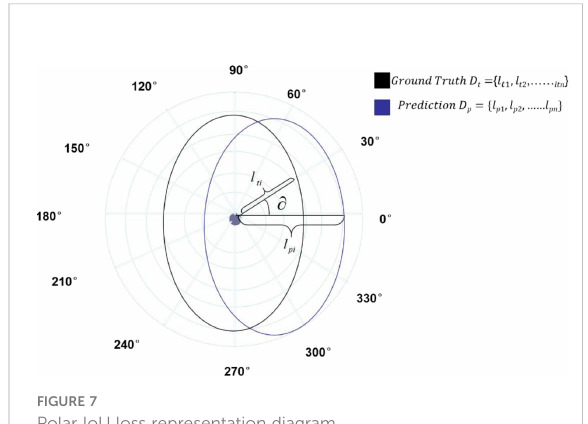
FIGURE 7 Polar IoU loss representation